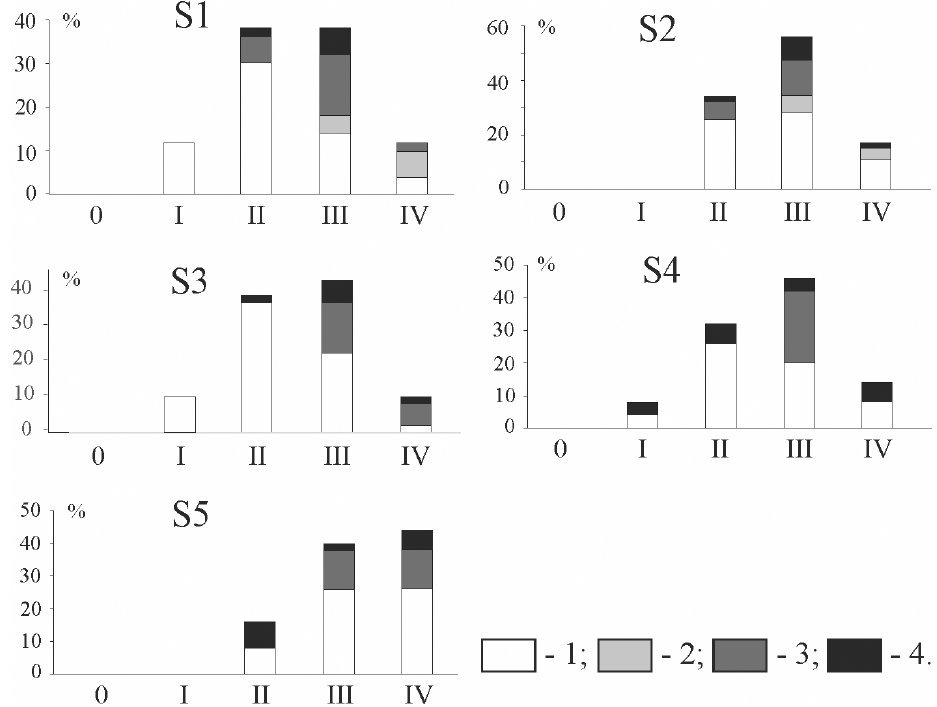
Figure A4. Distribution of quartz sand grains from section NS-20 by roundness and dullness. (1) Glossy; (2) quarter-matte; (3) half-matte; (4) matte; 0, I, II, III and IV are grades of roundness according to Khabakov (1946).